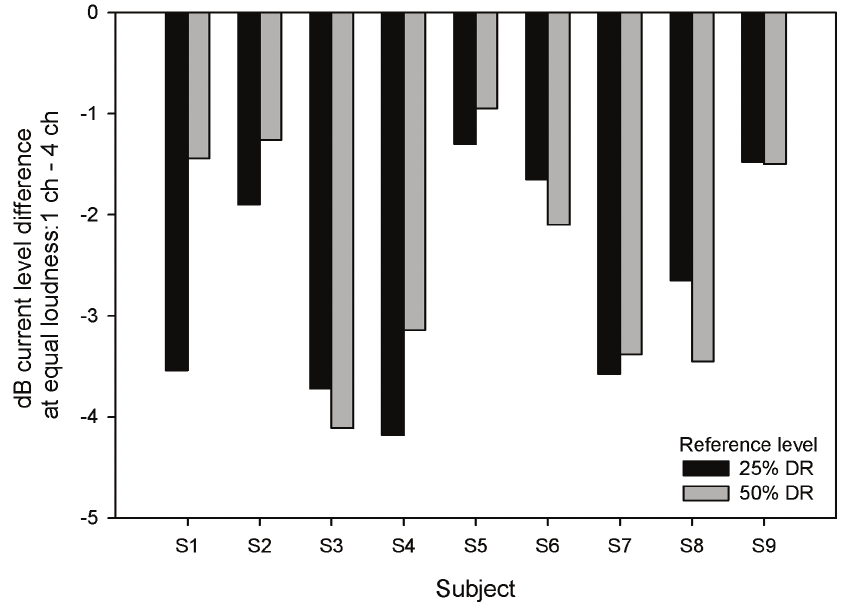
Figure 2. Loudness balancing between single- and multi-channel stimuli. The y-axis shows the current level adjustment needed to maintain equal loudness between 4-channel stimuli and the reference (single-channel, 500 pps, electrode C). The black bars show data referenced to 25% DR and the gray bars show data referenced to 50% DR. The error bars show the standard error.